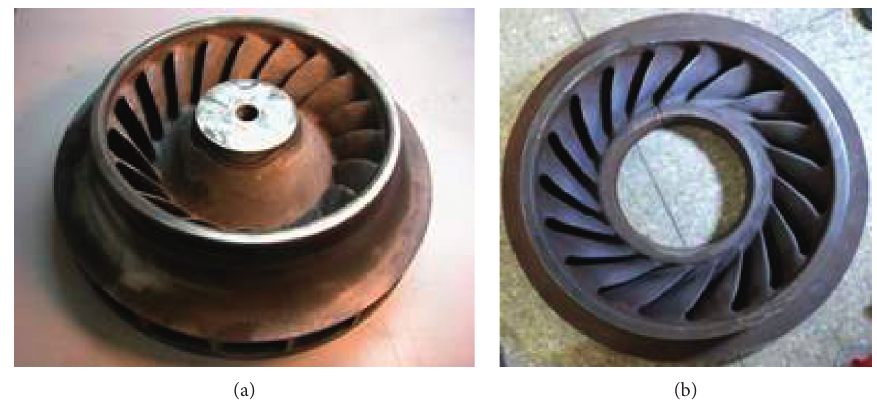
Figure 2: No. 3 (a) and No. 5 (b) reference impellers.